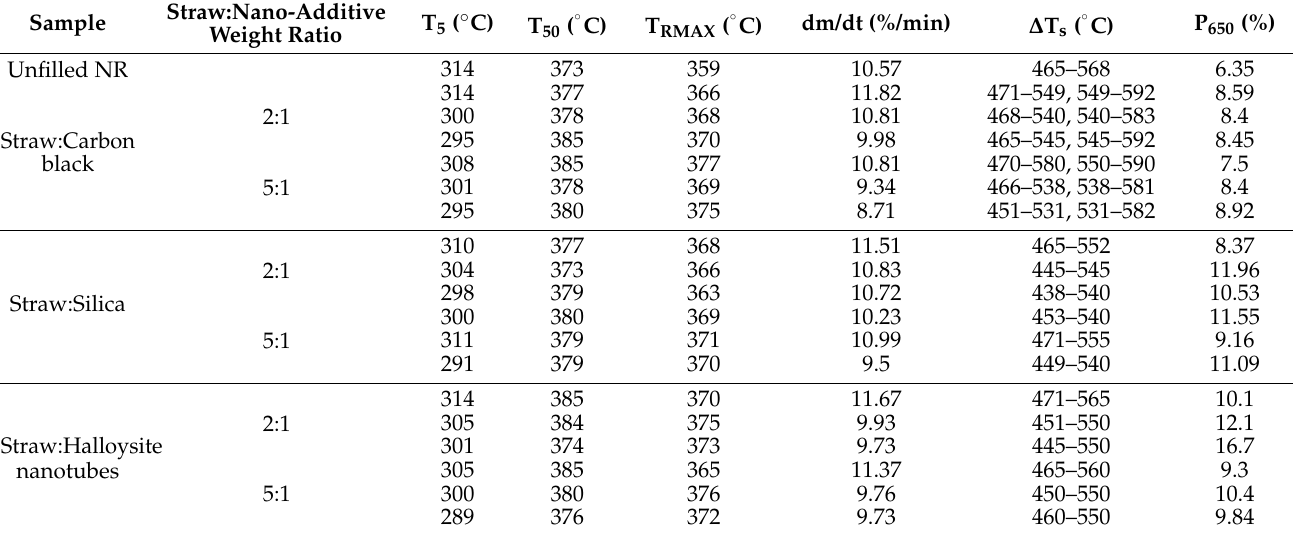
Figure 17. Thermal curves of unfilled vulcanizate (reference sample). Table 6. Results of thermal analysis of biocomposites made of natural